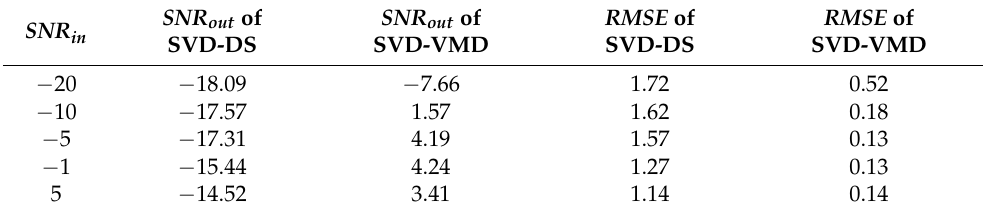
Table 3. Denoising performance with different SNR in